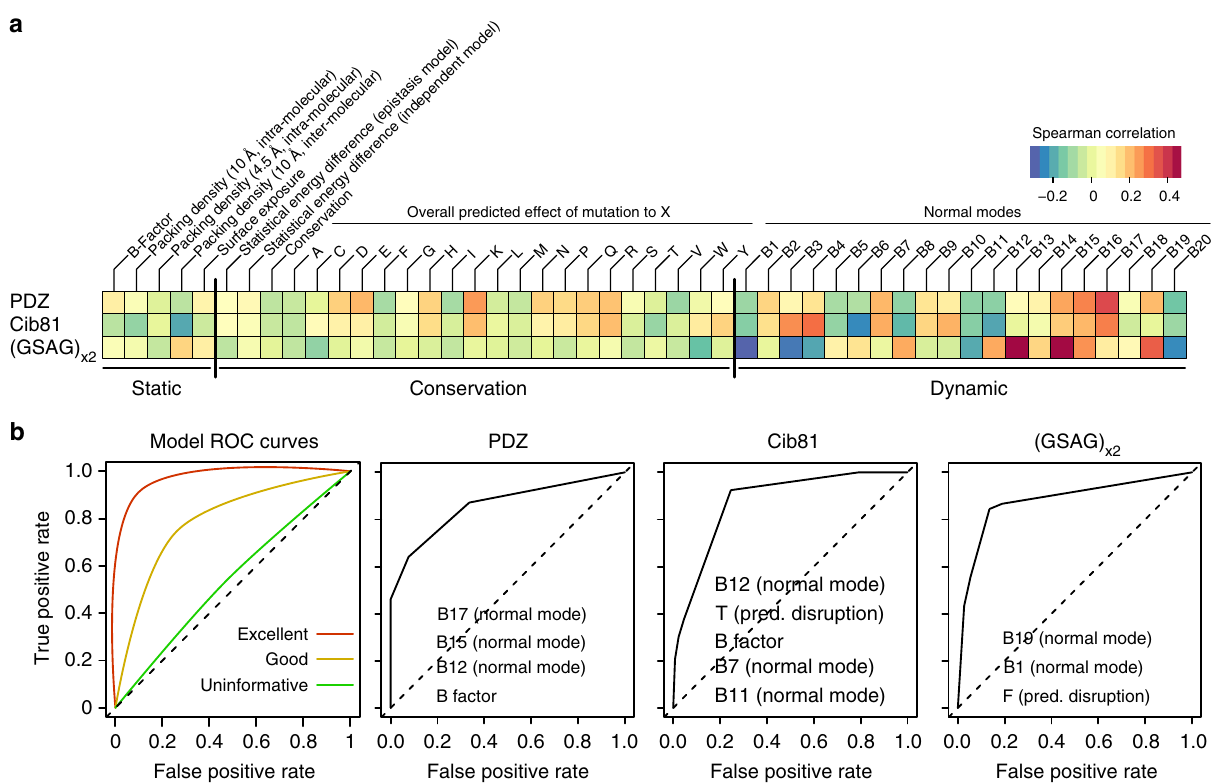
Fig. 4 Parameter correlation and model performance. a Spearman correlations between permissibility for the inserted domain indicated on the left with the calculate property indicated on the top. Vertical bars separate feature categories (static, conservation, and dynamic). Dynamic protein properties show strong correlation, while correlation with static and conservation properties is spurious. b Model performance as measured with receiver operator characteristic (ROC) curves for each domain. Each decision tree model was evaluated using 10-fold cross-validation (see Methods for details). Example of ROC curves for models with varying performance are shown on the leftmost panel. For each domain, the top predictive properties used in decision trees are indicated on the ROC